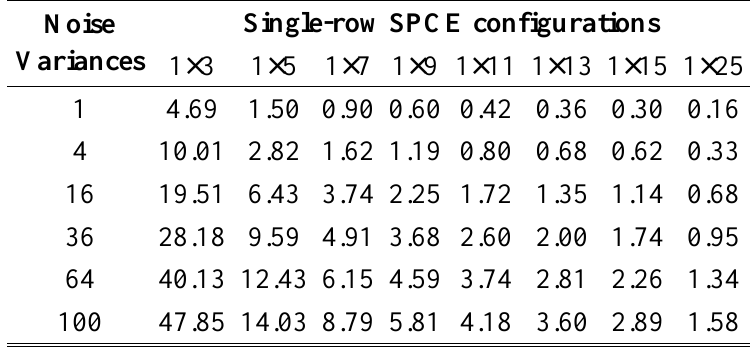
Table 2. Relative errors in percent of the ego-translation for different single-row SPCE configurations with various noise variances.